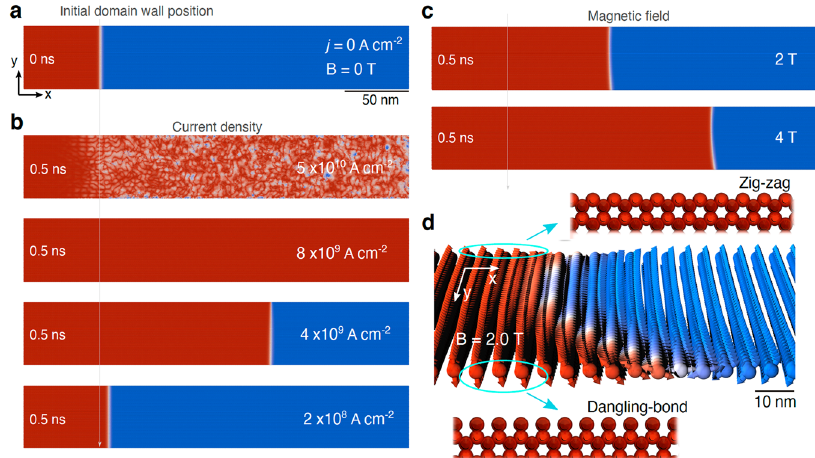
Fig. 4 Field- and current-induced domain wall dynamics in a 2D antiferromagnet. a Snapshot of the initial domain wall con fi guration ( j = 0, B = 0) used for both current and fi eld after initial equilibration. The initial time is set to t = 0 ns on the wall dynamics. A 300 nm × 50 nm fl ake is considered in all simulations. b , c Snapshots of the domain wall dynamics in MnPS 3 induced by different electrical currents (2 × 10 8 – 5 × 10 10 A cm − 2 ) and magnetic fi elds (2 T and 4 T), respectively. The dynamics is shown at the same time evolution of 0.5 ns. Turbulent states are observed for large current densities where domain walls are non-existent. d Close look of the snapshot of the fi eld-induced domain wall motion at B = 4.0 T in c . The presence of different edges (zigzag and dangling-bond) terminating the layer along y induces a bending of the wall pro fi le under the fi eld and consequently a slight asymmetry in the displacement of the wall. Only Mn atoms in the honeycomb lattice are